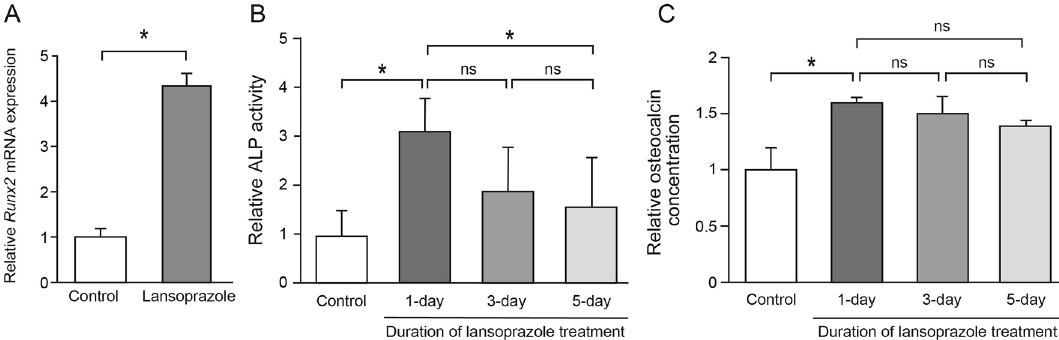
Figure 2. Short-term treatment with soluble lansoprazole facilitates osteoblastic differentiation of human mesenchymal stem cells. ( A ) Expression levels of endogenous Runx2 mRNA in soluble lansoprazole-treated commercially available human MSCs. Cells were treated with soluble lansoprazole for 1 day at the beginning of osteogenic induction. The relative expression levels were normalized to the mean of the control. ( B ) ALP activity of cell lysates of soluble lansoprazole-treated commercially available human MSCs. Cells were cultured in the osteogenic medium for 14 days and treated with soluble lansoprazole for one, three, or five days at the beginning of osteogenic induction (day 0). The ALP activities were determined on day 5. The relative activity was normalized to the mean of the control. ( C ) Osteocalcin concentration of cell lysates of soluble lansoprazole- treated commercially available human MSCs. Cells were cultured in the osteogenic medium for 14 days and treated with soluble lansoprazole for one, three, or five days at the beginning of osteogenic induction (day 0). The osteocalcin concentrations were determined on day 14. The relative concentration was normalized to the mean of the control. In ( A – C ), the mean and SD ( A , n = 3; B and C , n = 6) are indicated. ( A ) * p < 0.05